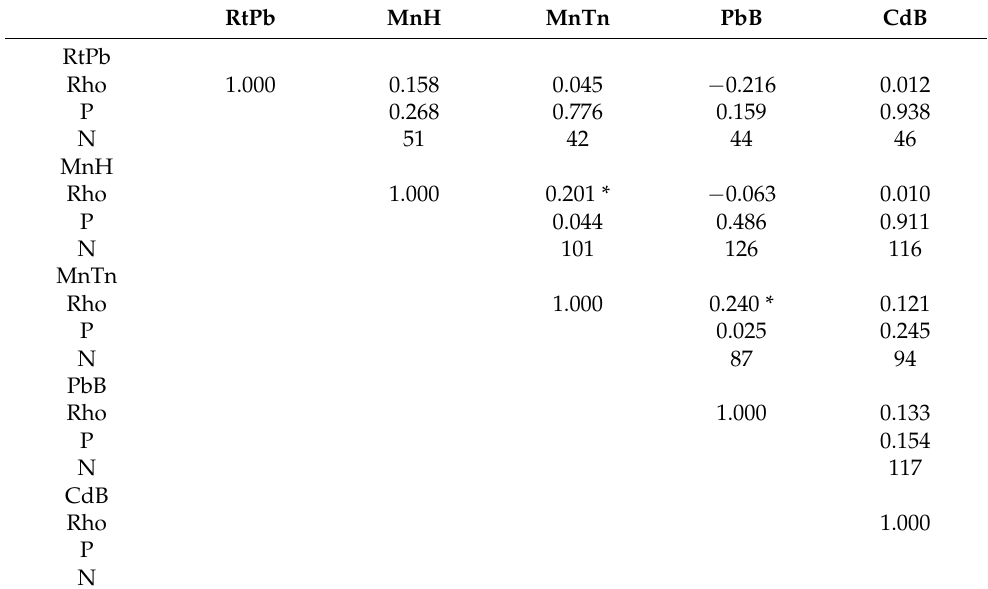
Table 3. Spearman correlation matrix between environmental markers and exposure